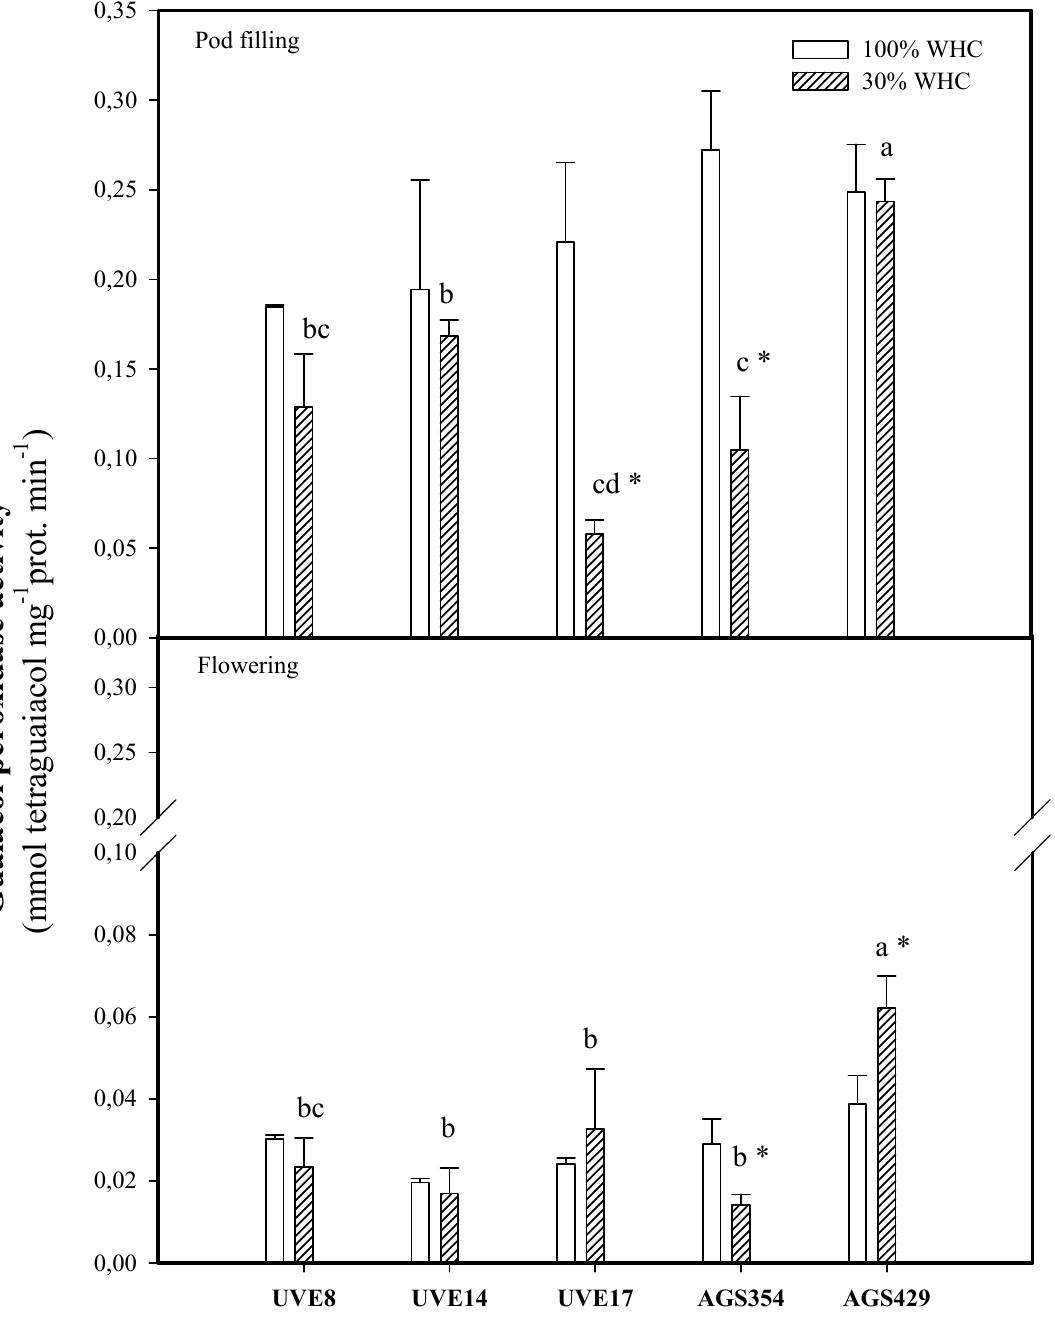
Figure 6. Guaiacol peroxidase (GPX) activity for five vegetable-type soybean cultivars subjected to two water treatments at flowering and pod-filling stages. Values represents means ± SD ( n = 3). Letters represent significant differences/similarities in GPX activity for various cultivars under severe water stress at 30% water holding capacity (WHC), * represents significance at p ≤ 0.05.